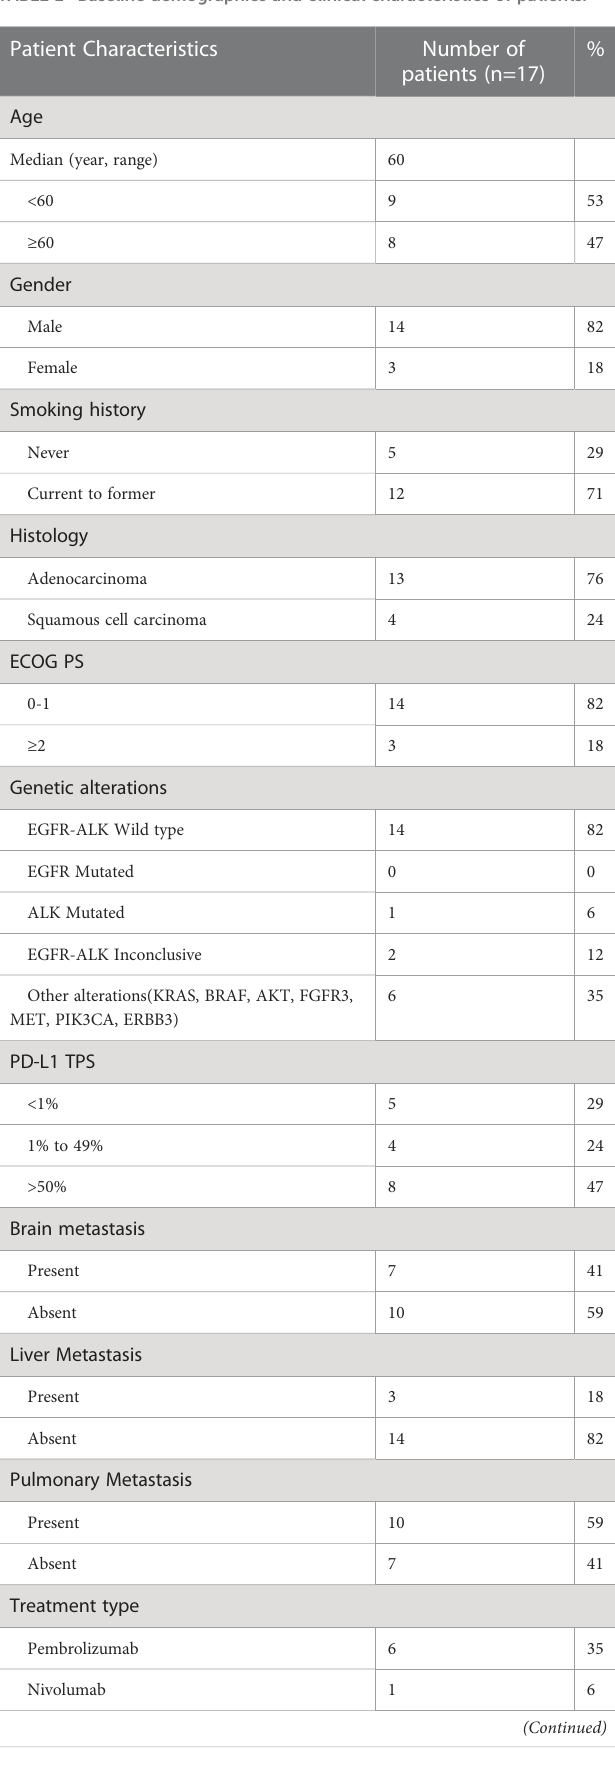
TABLE 1 Baseline demographics and clinical characteristics of